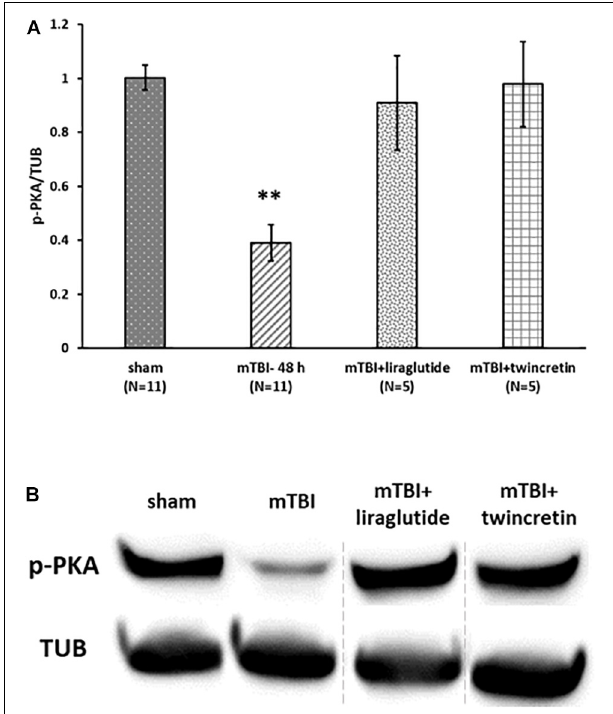
FIGURE 9 | Liraglutide and twincretin treatments block mTBI-induced reduction in p-PKA expression in the ipsilateral cortex. (A) Graph showing the p-PKA expression levels in ipsilateral/right cortex 48 h following mTBI. One-way ANOVA followed by Fisher’s LSD post hoc analysis revealed a significant reduction in p-PKA expression in ipsilateral injured cortex 48 h following mTBI as compared to sham [ F (5,28) = 12.603; p < 0.001, ∗∗ p < 0.01]. Treatment with either liraglutide or twincretin reduced the decline observed in mTBI affected brains ( ∗∗ p < 0.01, respectively). Values are mean ± SEM. (B) Representative images of gel electrophoresis followed by immunoblot analysis using antibodies against p-PKA and α -tubulin in the ipsilateral cortex. A crop of the original image was performed, and sample number 3 was replaced by sample number 8, since the sample of mTBI + liraglutide was on loading site number 8 of the